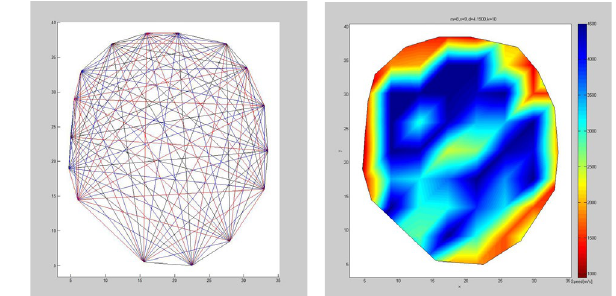
Figure 11 . Ultrasonic detection data and CT mapping, showing a general deterioration of the marble on the head’s surface. (Source: Honglin